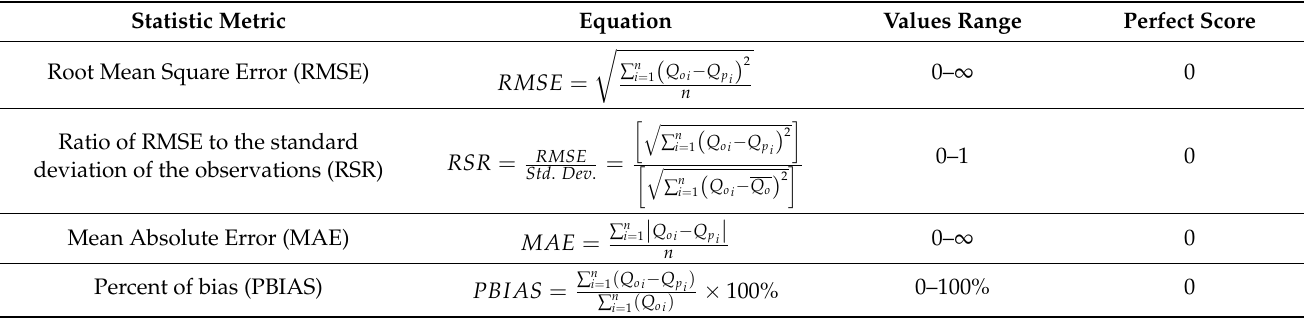
Table 2. Commonly used statistical metric for evaluating the two